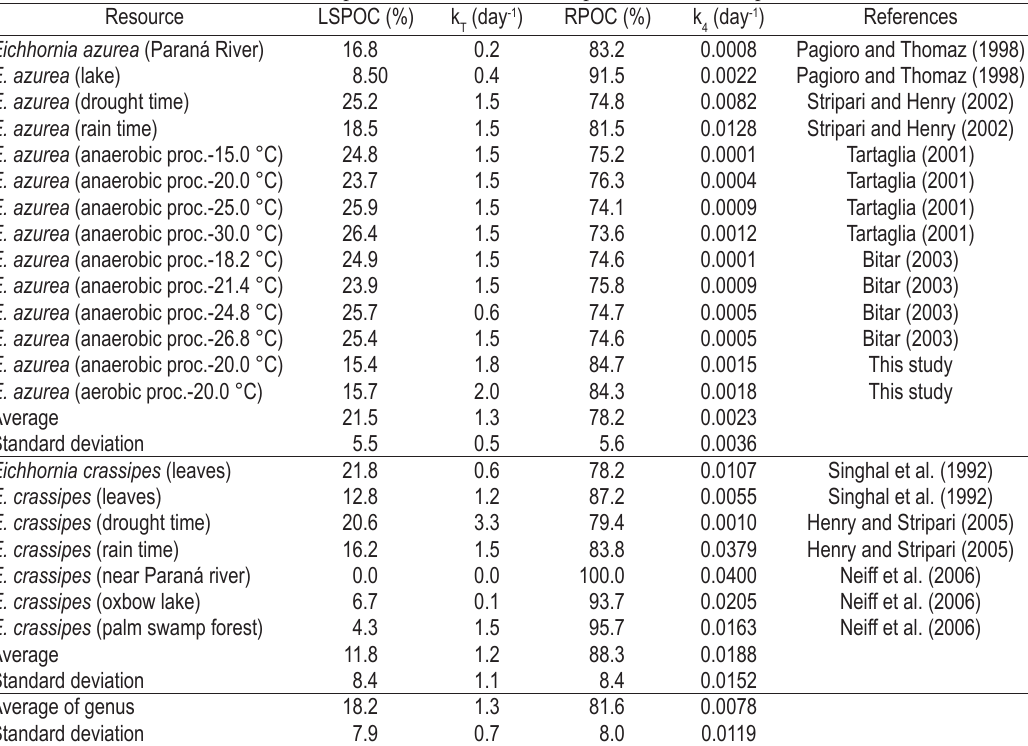
Figure 1. Aerobic (a) and anaerobic (b) decomposition of Eichhornia azurea : variations of particulate organic carbon (POC), dissolved organic carbon (DOC) and total inorganic carbon (TIC). Table 2. LSPOC (labile-soluble particulate organic carbon), RPOC (refractory particulate organic carbon, k (total T loose mass constant rate related with LSPOC) and k (mineralization of RPOC constant rate) estimated to the 4 adopted model (Equation 1) from decomposition studies of Eichhornia under different environmental conditions. Some notes about the studies and/or experimental conditions are presented into the